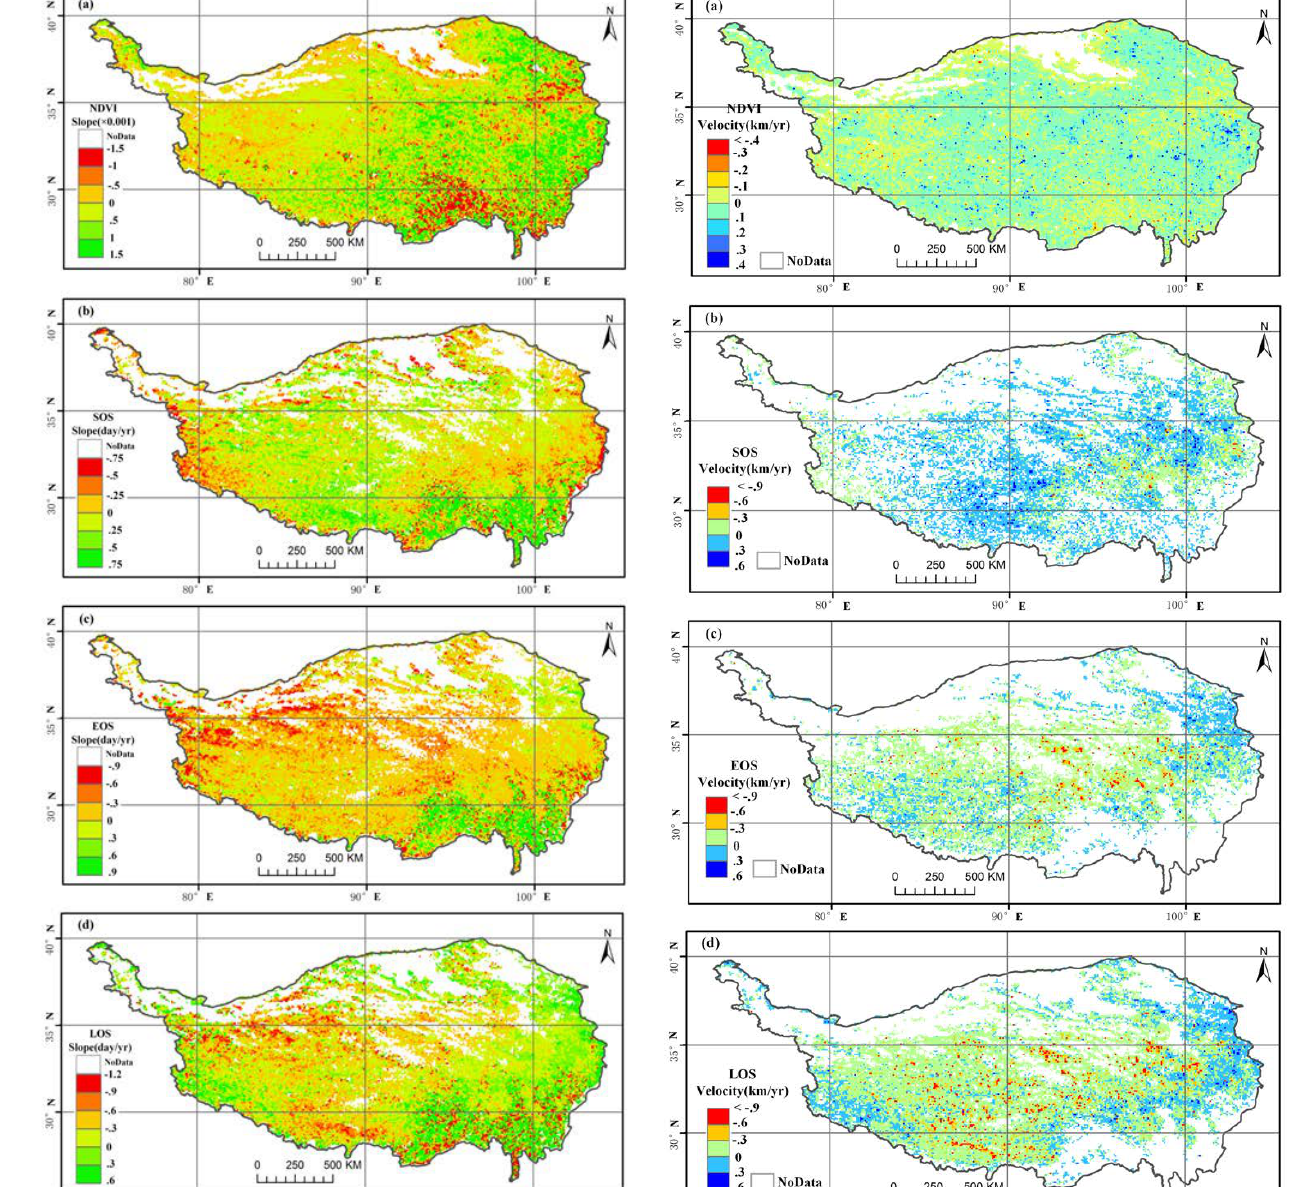
Figure 2. NDVI temporal trend (a) and the histogram (b).